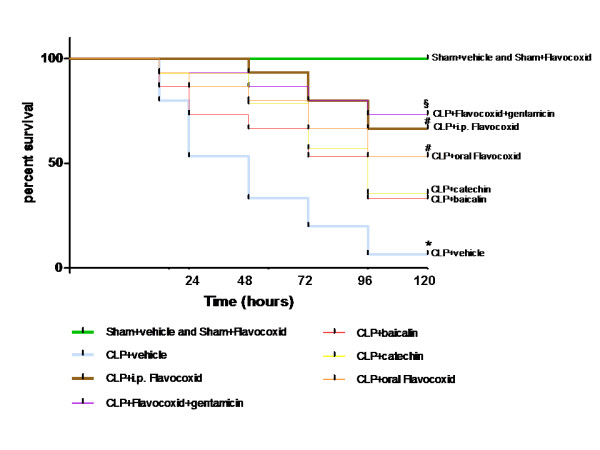
Effect of flavocoxid on survival in mice with cecal ligation and puncture (CLP). C57BL/6J mice were subjected to CLP (n = 15 per group) or sham operation (n = 10 per group). All the CLP animals were fluid resuscitated with sterile NaCl 0.9% saline solution (1 ml/mouse). Animals were treated with flavocoxid (20 mg/kg, ip) with and without gentamicin (3.2 mg/kg, sc), or baicalin (16 mg/kg, ip), or cathechin (4 mg/kg, ip), or vehicle (NaCl 0.9%) 1 hour after surgery, repeated every 12 hours. Mouse survival was monitored every 24 hours for a total of 120 hours, and expressed as percentage of mice survived at each time point. *P < 0.01 compared with sham + vehicle or flavocoxid; #P < 0.01 compared with CLP + vehicle; §P < 0.01 compared with CLP + vehicle.